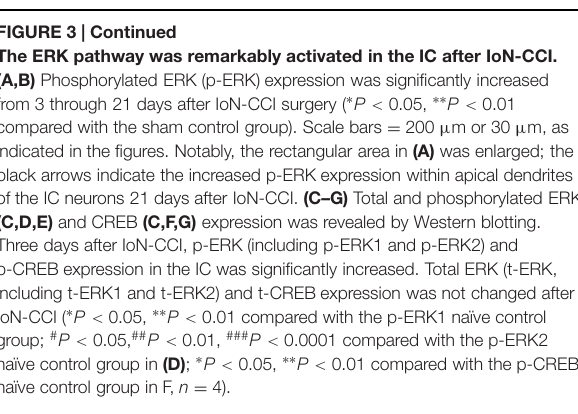
Frontiers in Cellular Neuroscience |